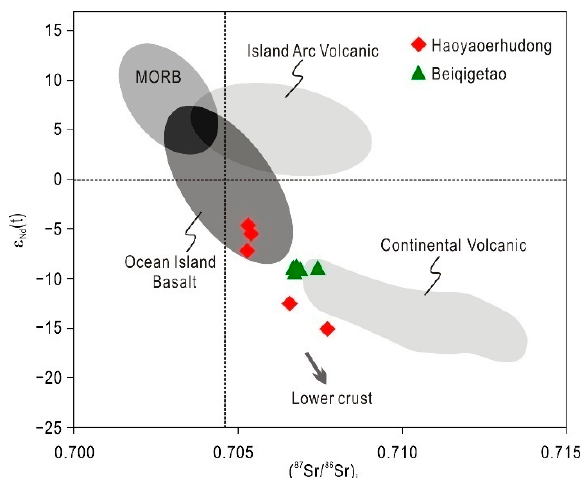
Figure 9. ε Nd(t) vs. ( 87 Sr/ 86 Sr) i diagram for the Haoyaoerhudong gabbro. The contents of MORB, OIB, island arc volcanics and continental volcanics are from [15,56,57]. The trend to the lower crust is from [58]. The data for the green triangles are from